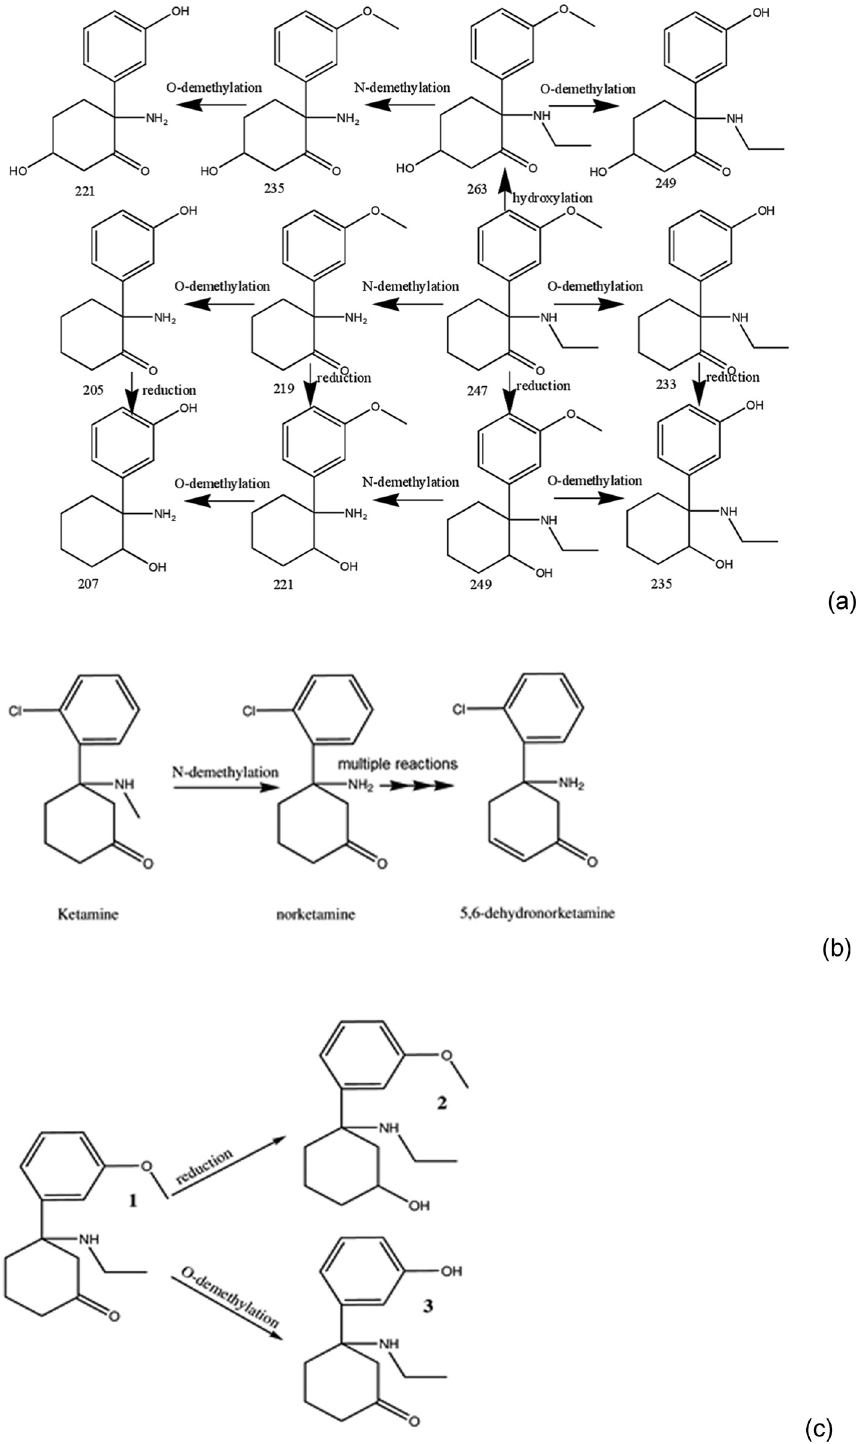
Figure 3: ( a ) Suggested phase I metabolic pathway for MXE ( extrapolated from published data ) , ( b ) metabolic pathway of ketamine, and ( c ) the present proposed metabolic pathway of MXE, where ( 1 ) represents MXE, ( 2 ) dihydro - MXE, and ( 3 ) nor -